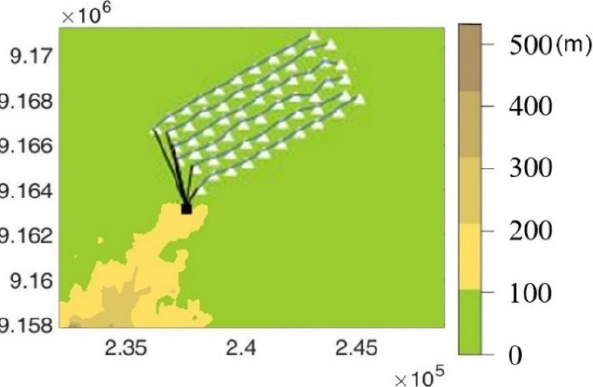
Figure 13. Wind farm cabling for wind turbine A in Area-1. The blue lines represent collection system cables, and the black lines represent transmission lines. The square represents the onshore substation.